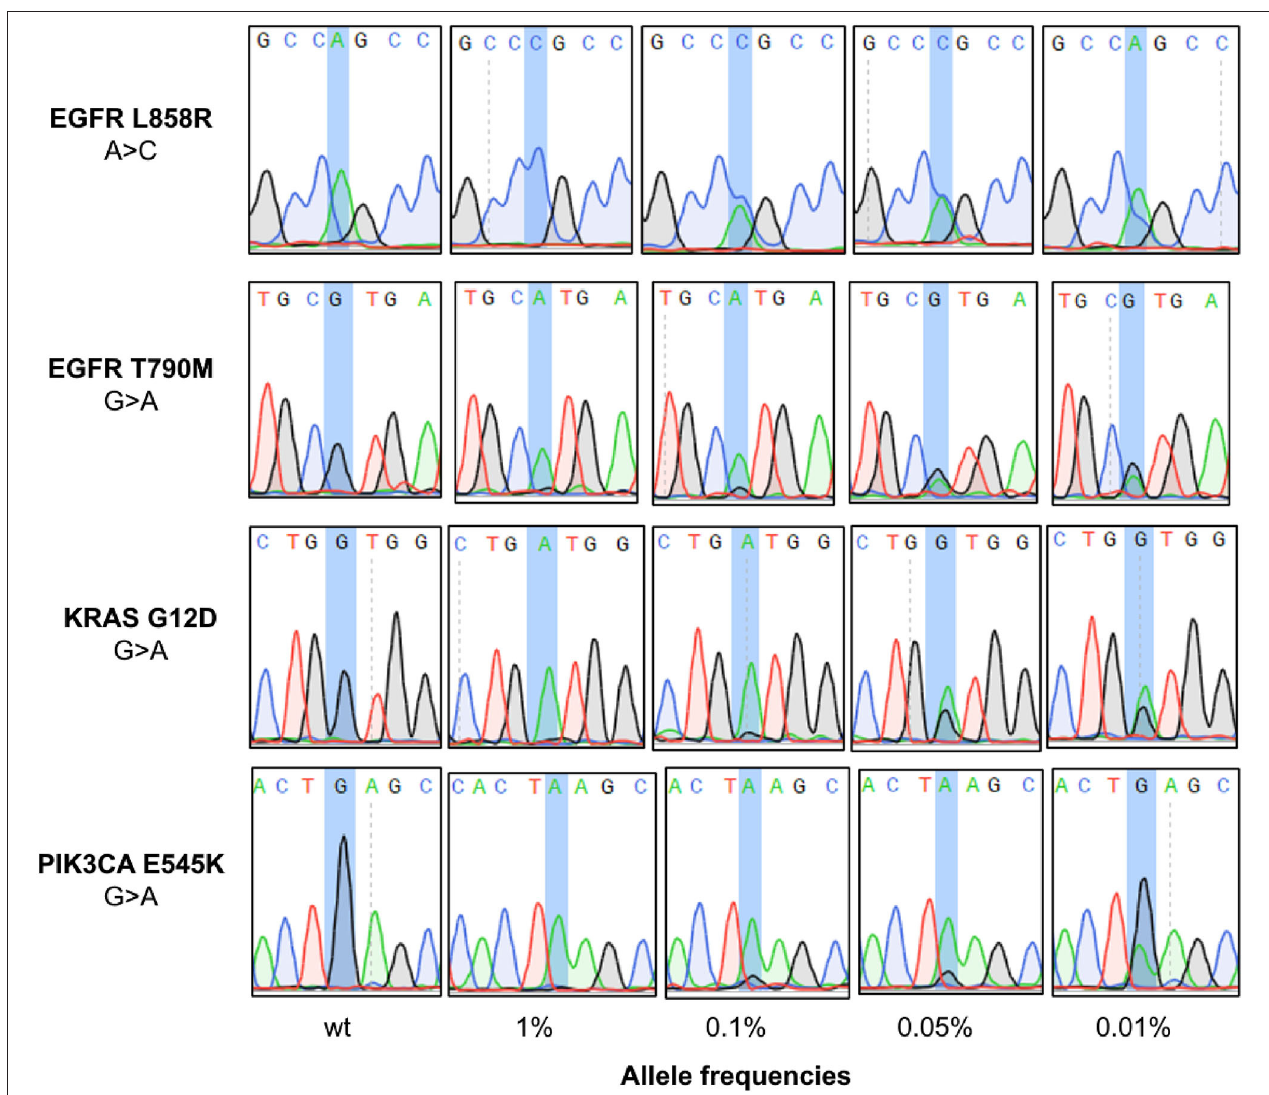
FIGURE 2 | Application of PEAC enrichment followed by Sanger sequencing on NSCLC driver mutations. The mutation status can be determined by read out of the Sanger chromatograph. From the top to the bottom panels are the status of WT, 1, 0.1, 0.0%, and 0.01% reference standards after PEAC enrichment for EGFR L858R, EGFR T790M, KRAS G12D, and PIK3CA E545K